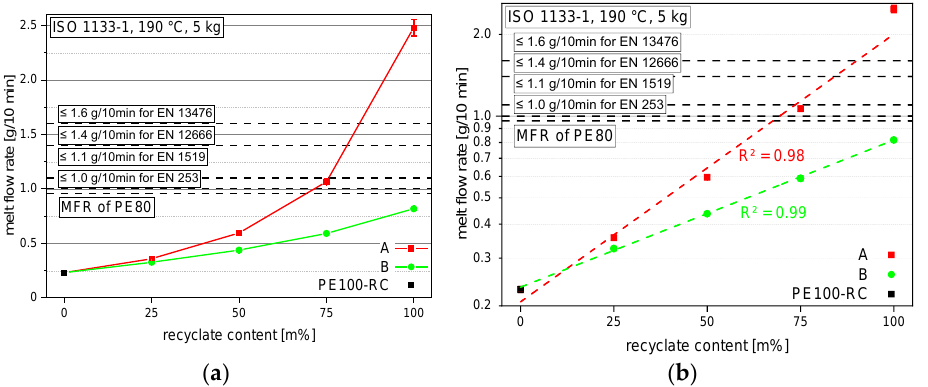
Figure 3. Graphical illustration of MFR values of the virgin material PE100-RC (as 0 m% recyclate content data point for both compounding series) both recyclates (at 100 m% recyclate content) and the compounds containing 25 m%, 50 m%, and 75 m% rPE-A and rPE-B, respectively. The data is plotted linearly ( a ) and logarithmically ( b ) to emphasize the logarithmic trend. The vertical bars show the sample standard deviation.